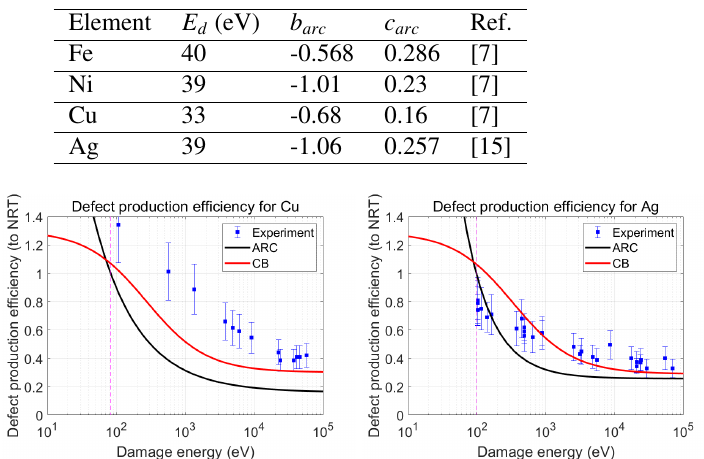
Table 1. Parameters for DPA calculation